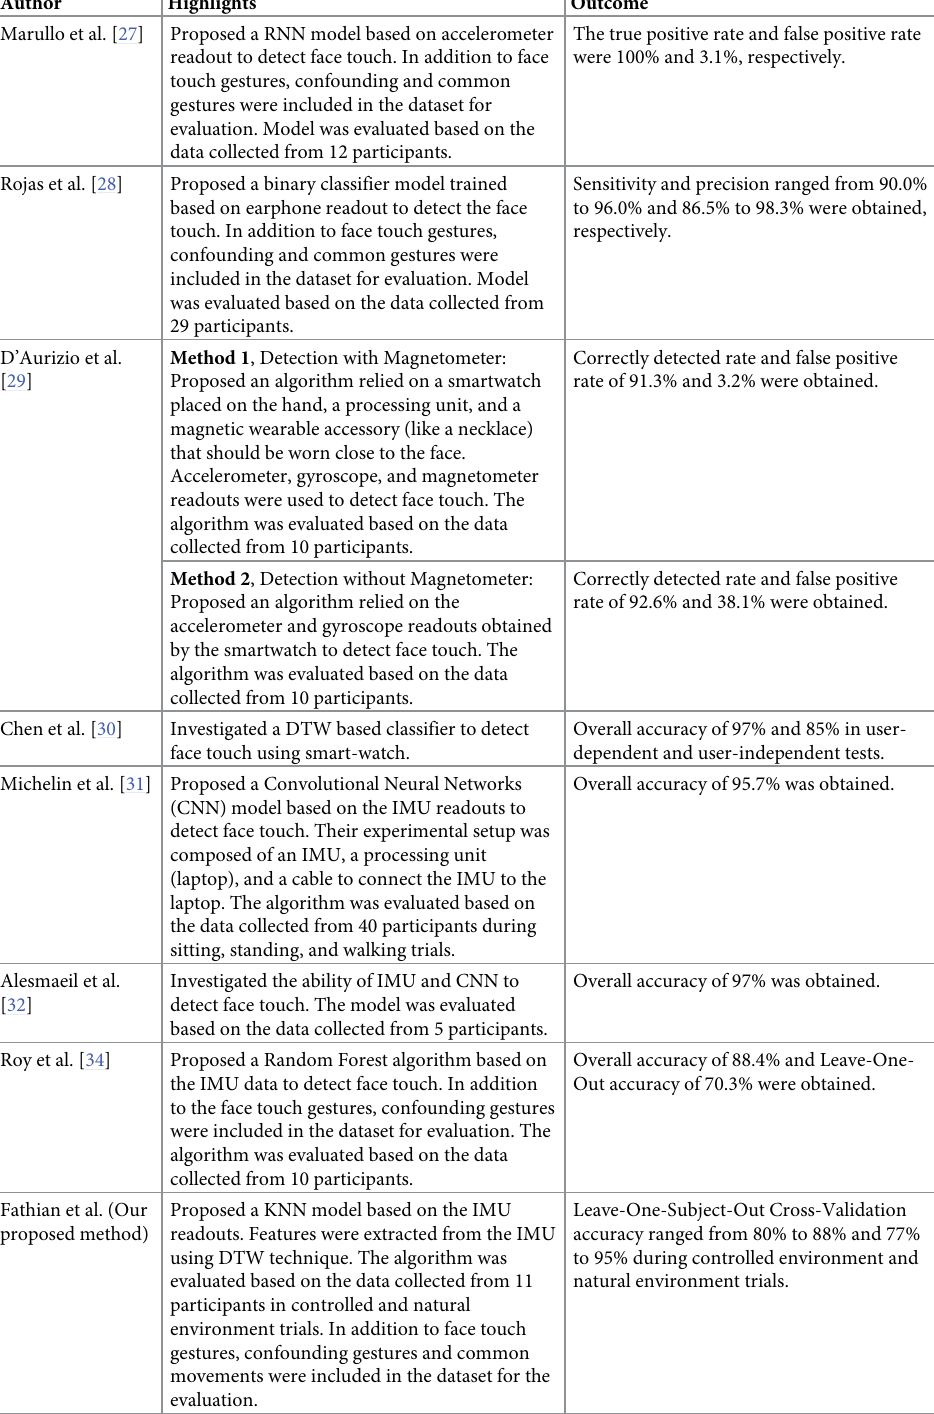
Table 3. Summary of the proposed algorithms, experimental procedure involved, and obtained outcomes in the studies investigated face touch